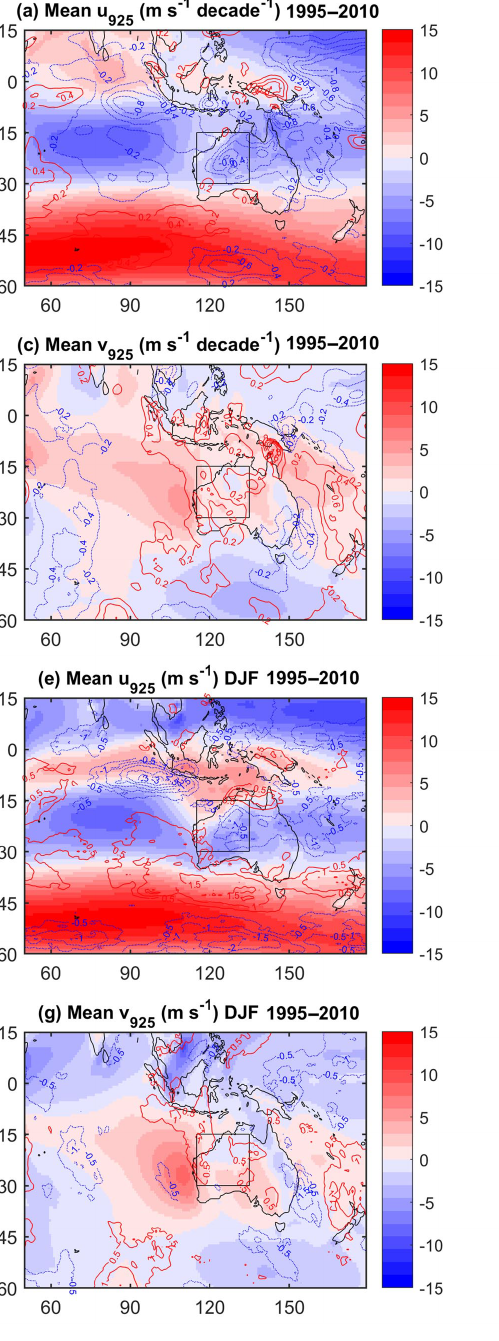
Figure 10. Close-up of Western Australia showing the mean monthly and DJF fields and trends (contours) of the u and v wind components at 925hPa (shaded). The area of focus (where IWV trends are most intense in ERA-Interim) is marked by a